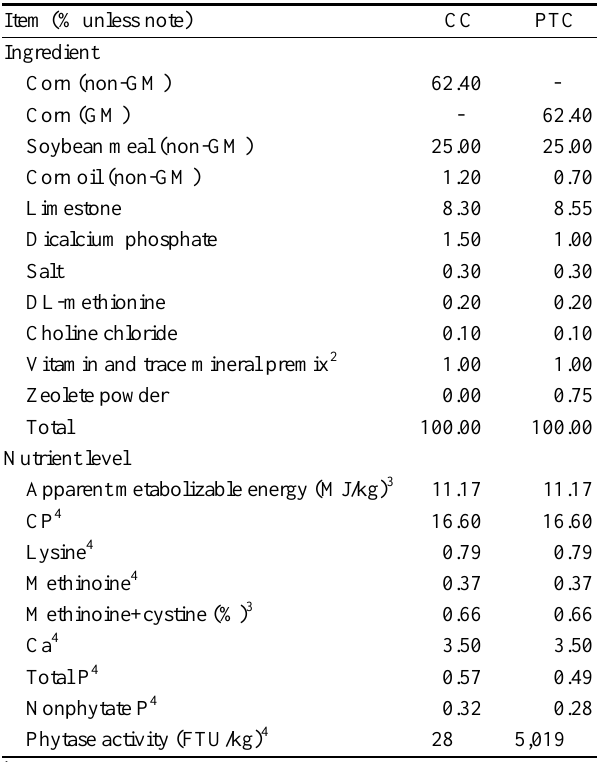
Table 1. The ingredient and nutrient composition of experimental diets (as-fed basis)